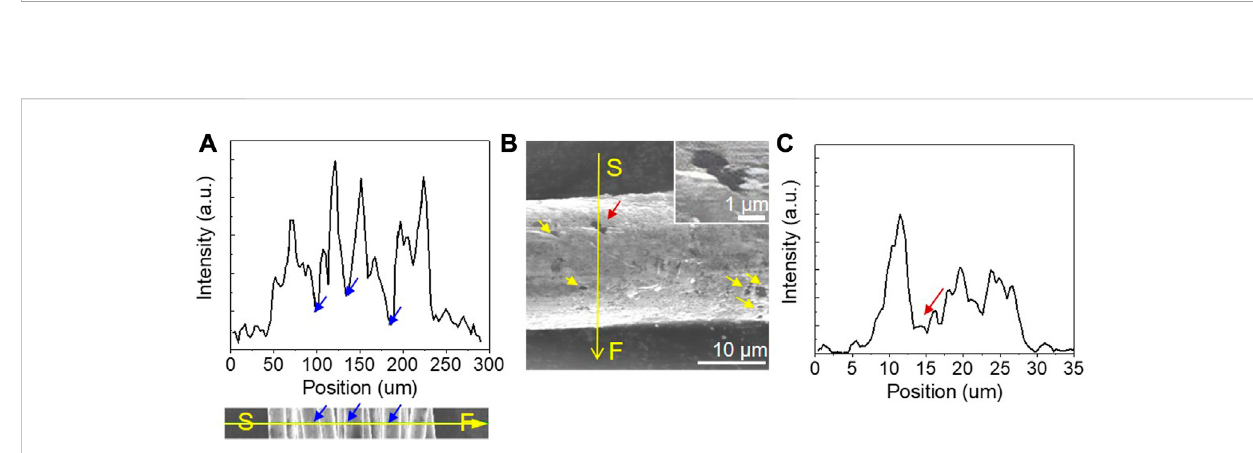
FIGURE 8 SEMimagesof (A) a fi lamentand (B) astrandofthepartlygold-coatedSCCY(inset:anenlargedimagemarkedbytheredarrow). (A,C) EDSspectraof gold content variation along the scan line from S to F shown in (A, B) ,